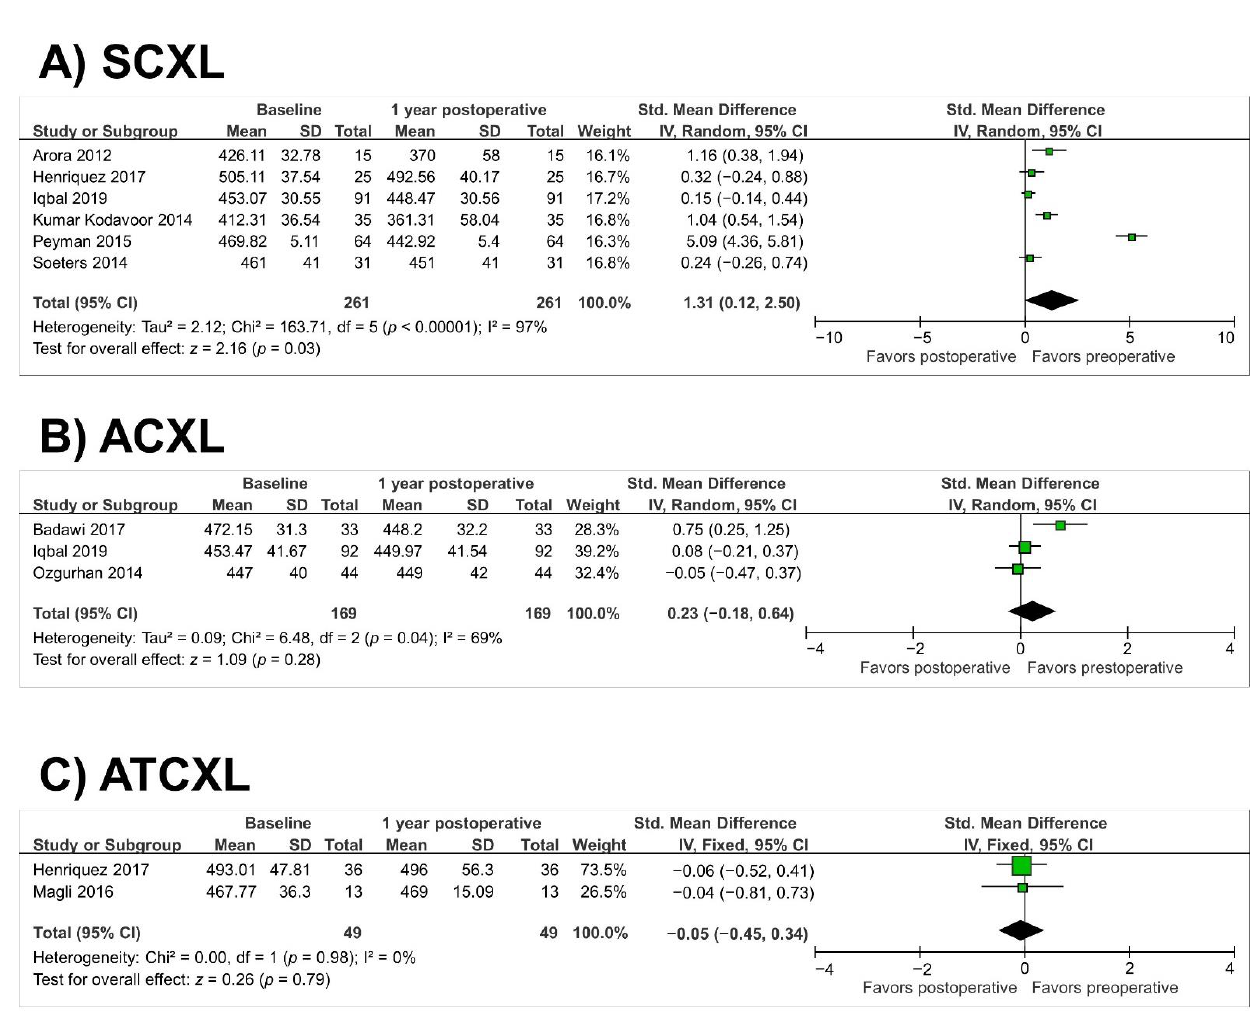
Figure 3. Forest plot of thinnest corneal thickness 1-year standardized mean differences in micrometres in studies included in meta-analysis. ( A ), standard cross-linking (SCXL); ( B ), accelerated CXL (ACXL), ( C ), accelerated and transepithelial CXL (ATCXL). IV = inverse variance, CI = confidence interval, Tau 2 = tau-square statistic, Chi 2 = chi-square statistic, df = degrees of freedom, I 2 = I-square heterogeneity statistic, z = Z-statistic.